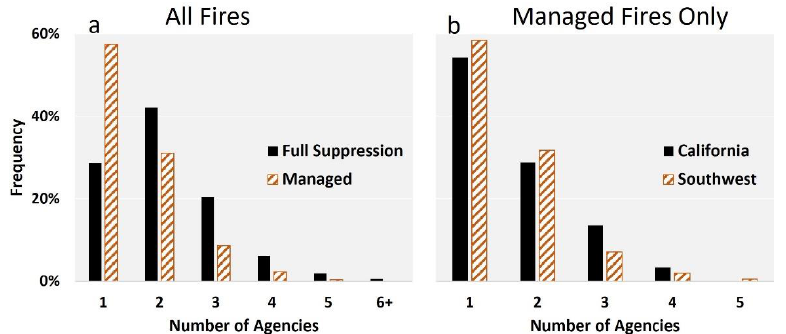
Figure 2. Comparisons of the number of land management agencies involved per fire between ( a ) fire management strategies (full suppression and managed wildfires) and ( b ) regions (California and the Southwest; for managed wildfires only). Full suppression wildfires in our study area in- cluded significantly more agencies compared to managed fires. Managed wildfires in California and the Southwest did not differ in terms of the number of agencies that were involved.